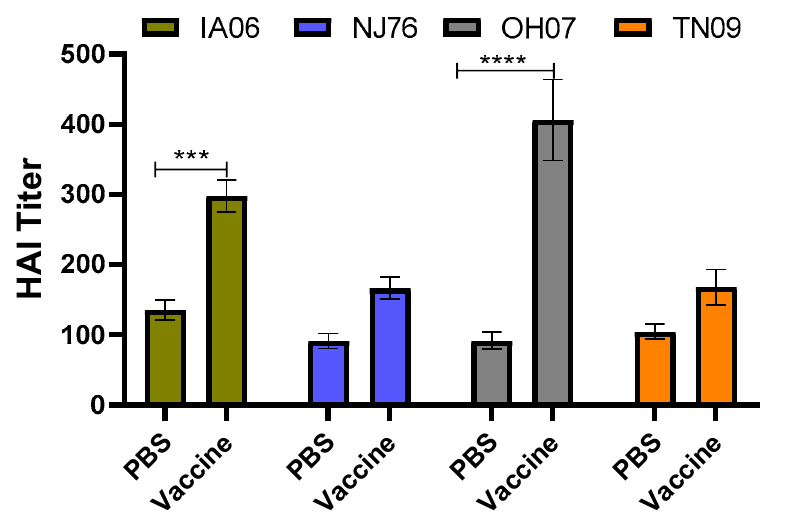
Figure 4. Serum antibody HAI titers from neonatal piglets infected with four parental viruses. Preg- nant sows were vaccinated with either inactivated TX98-129 vaccine or PBS. Piglets born from the sows were challenged with a reassortant virus (TX98-IA06, TX98-NJ76, TX98-OH07, TX98-TN09). Terminal serum samples at 5 DPC were subjected to HAI assay against each of the challenge viruses. HAI titers are defined as the reciprocal of the final serum dilution where inhibition of hemagglutina- tion was observed. Statistical significance was determined by one-way ANOVA (Tukey’s test) and is indicated with asterisks (***, p < 0.001; ****, p < 0.0001).